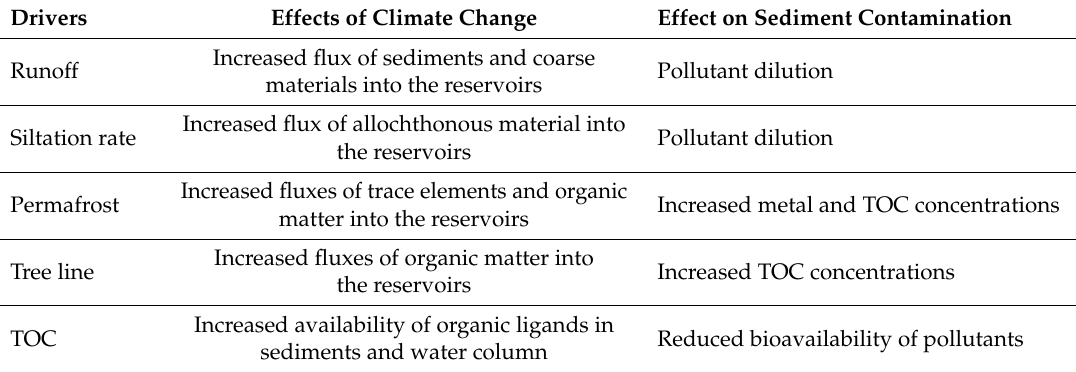
Figure 4. ( a ) Projection of rainfall erosivity in the study area (yellow square): map modified from Panagos et al. [43], representing the absolute difference of R-factor between 2050 projections and 2010 data. ( b – d ) Maps of Köppen–Geiger climate classification calculated from projected temperature and precipitation data (modified from Rubel et al. [10]): ( b ) present period (1976–2000) vs. projections for period 2076–2100 according to: ( c ) moderate (RCP2.6) case scenario; and ( d ) extreme (RCP8.5) case scenario. Table 4. Scenarios on possible effects of climate change on drivers affecting contaminant concentrations in reservoir sediments and, thus, on sediment contamination.